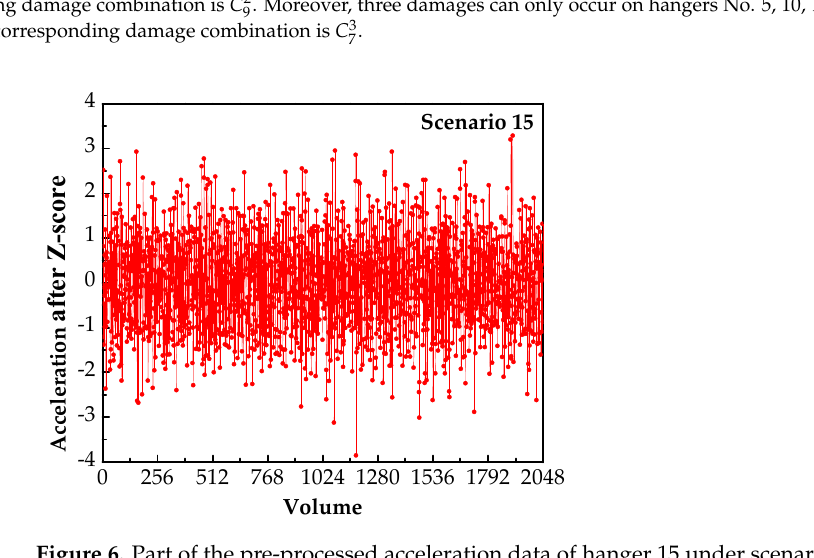
Figure 6. Part of the pre-processed acceleration data of hanger 15 under scenario 15.